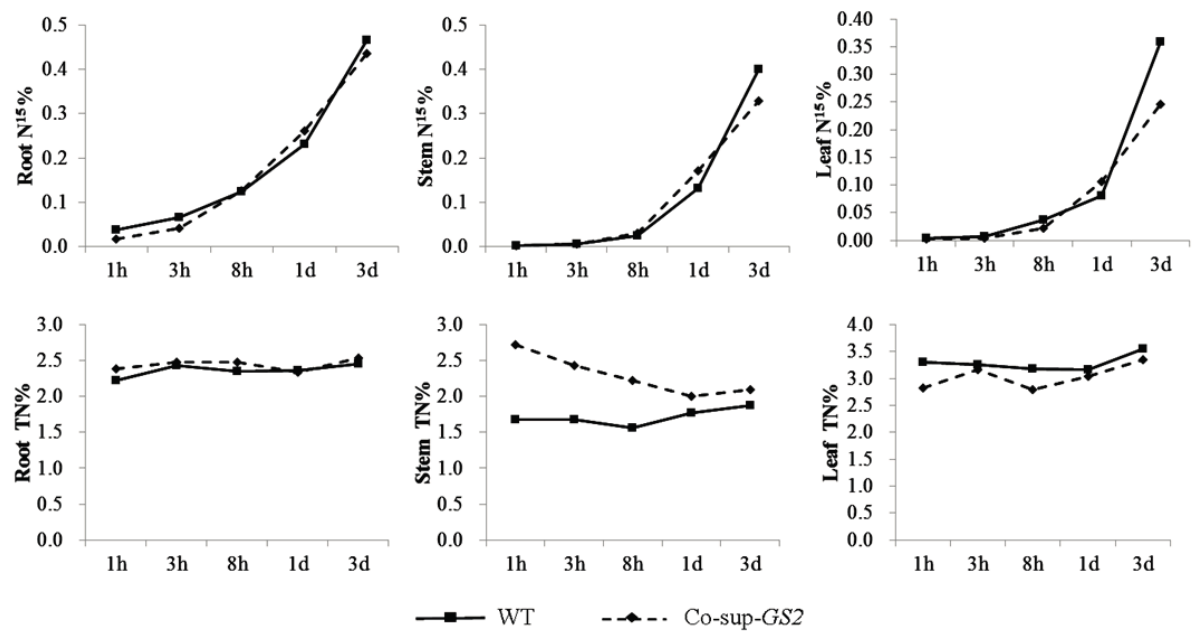
Figure 2. The 15 N ( 15 N%) and total nitrogen content (TN%) in the roots, stems and uppermost leaves of the GS2 -cosuppressed plants (Co-sup- GS2 ) and wild-type plants (WT) at 1 h, 3 h, 8 h, 1 day and 3 days after NH 4 NO 3 in the nutrient solution was replaced with 15 NH 415 NO 3 during the tillering stage. The values are the means from three biological replicated plant